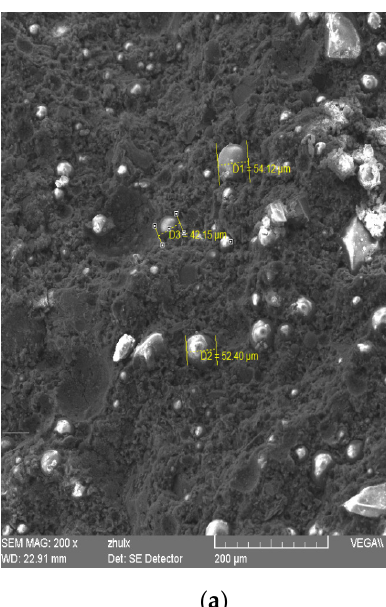
( b ) Figure 20. Process optimization window of modified cement sheath: ( a ) shear deformation; ( b ) extrusion deformation.